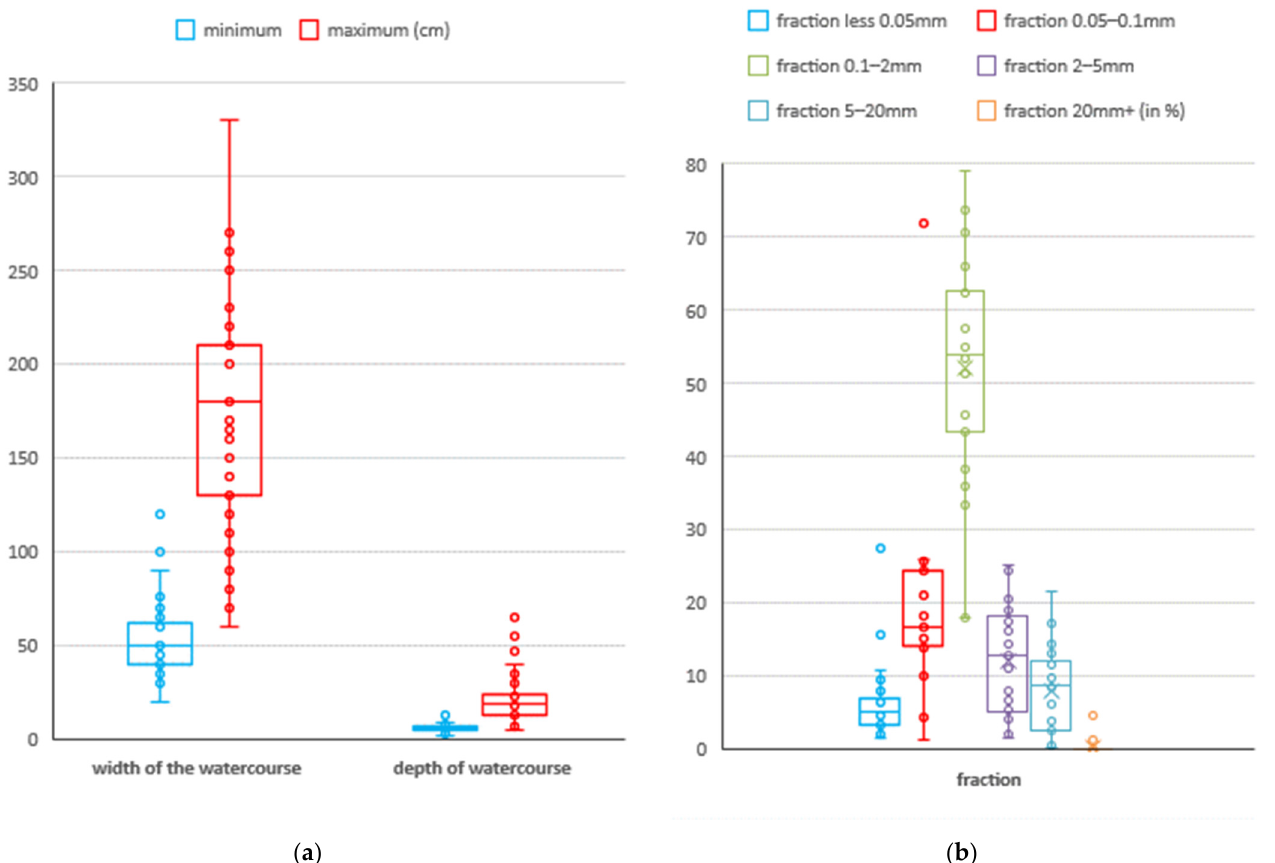
Figure 3. Characteristics of habitat at localities with Cordulegaster heros larvae ( n = 42): ( a ) width and depth of watercourses, ( b ) grain composition of the sediment.